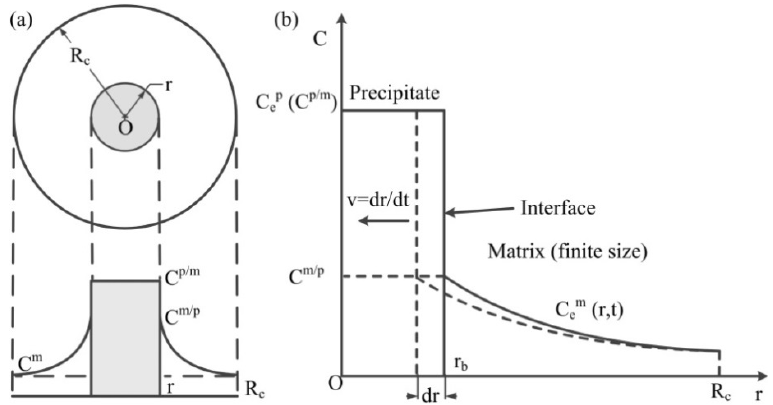
Figure 1. Dissolution model of a spherical precipitate in an aluminum alloy during SHT and the interfacial movement under the control of diffusion: ( a ) the dissolution model of a spherical precipitate; ( b ) the interfacial movement model.